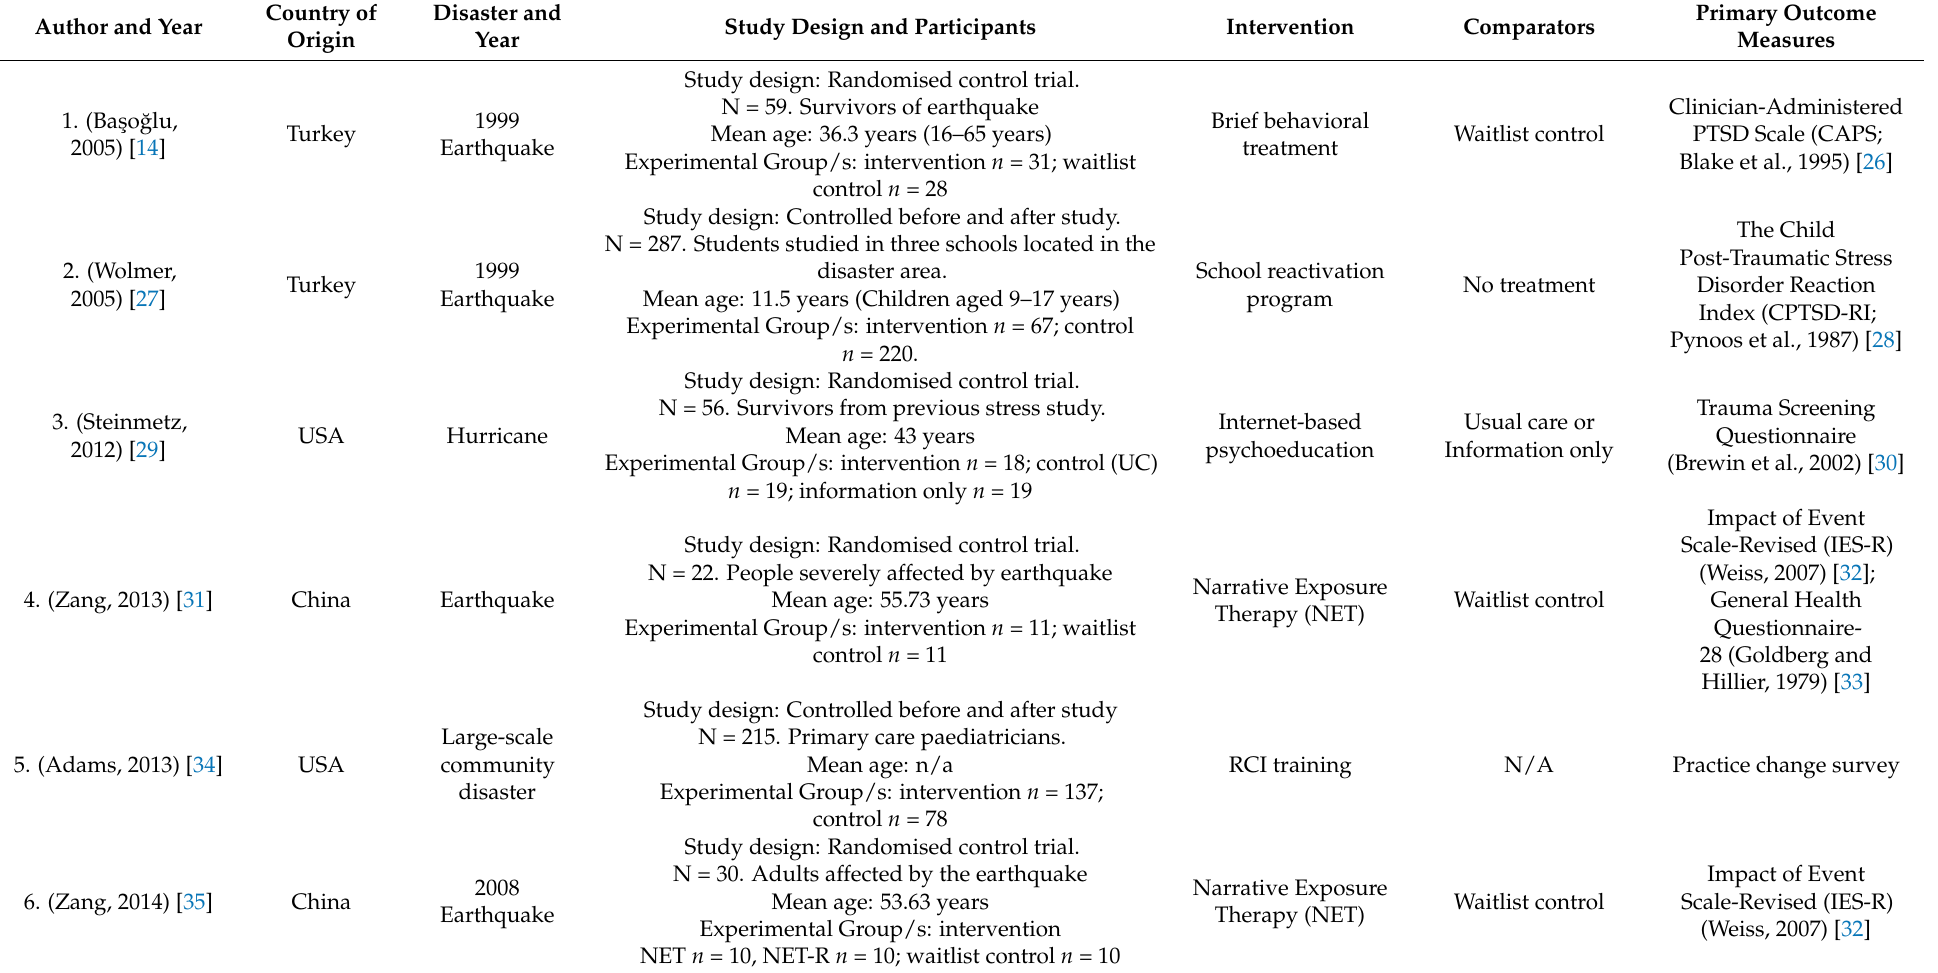
Table 1. Summary characteristics of included